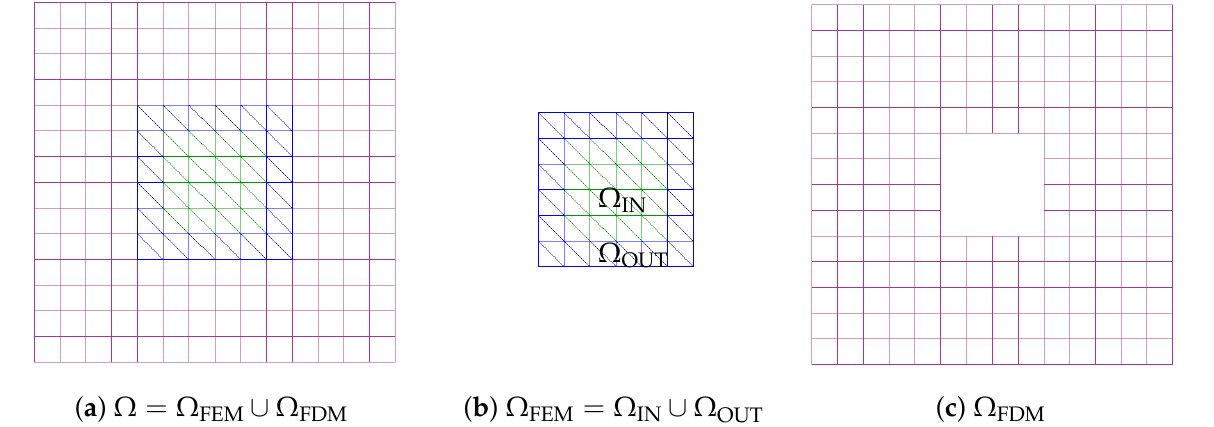
Figure 1. Domain decomposition and mesh discretization in Ω . The domain Ω presented on ( a ) is a combination of the quadrilateral finite difference mesh Ω FDM presented on ( c ), and the finite element mesh Ω FEM presented on ( b ).